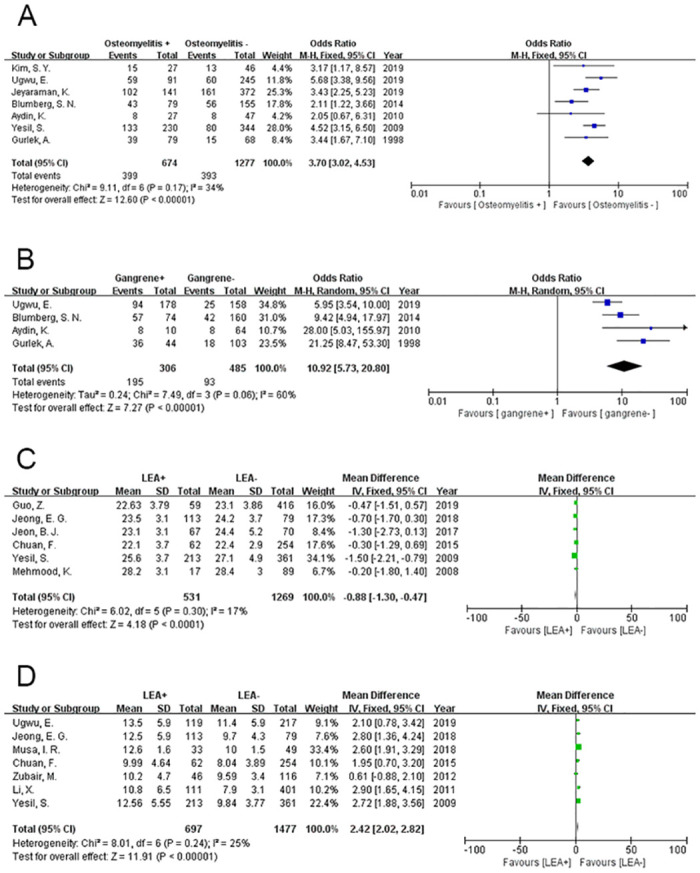
Meta-analysis results of the occurrence of LEA in the two groups.(A) Osteomyelitis; (B) Gangrene; (C) Body mass index; (D) WBC count.